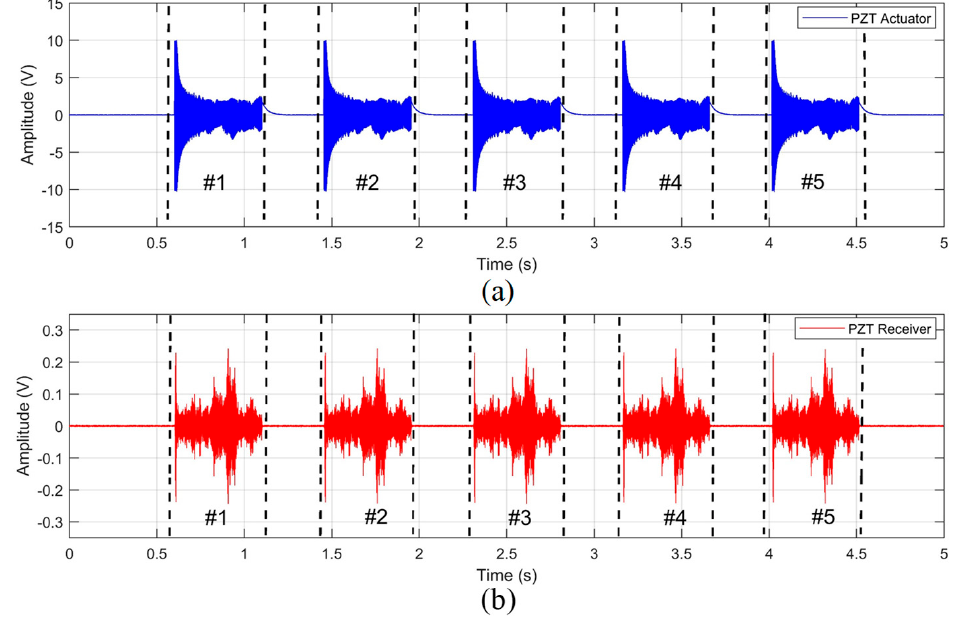
Figure 6. ( a ) Emitted signals packages and ( b ) received signals packages.